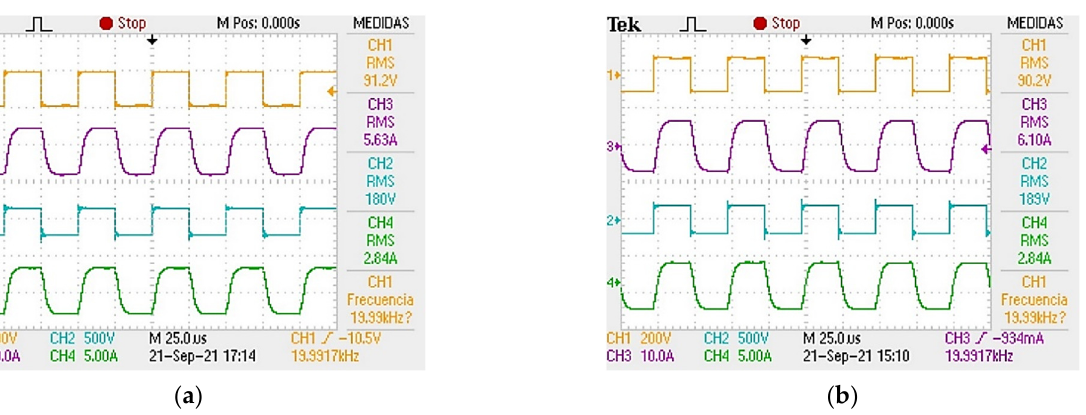
Figure 14. MFT input and output voltages and currents (50% P nom ): ( a ) Nanocrystalline, ( b ) Ferrite.